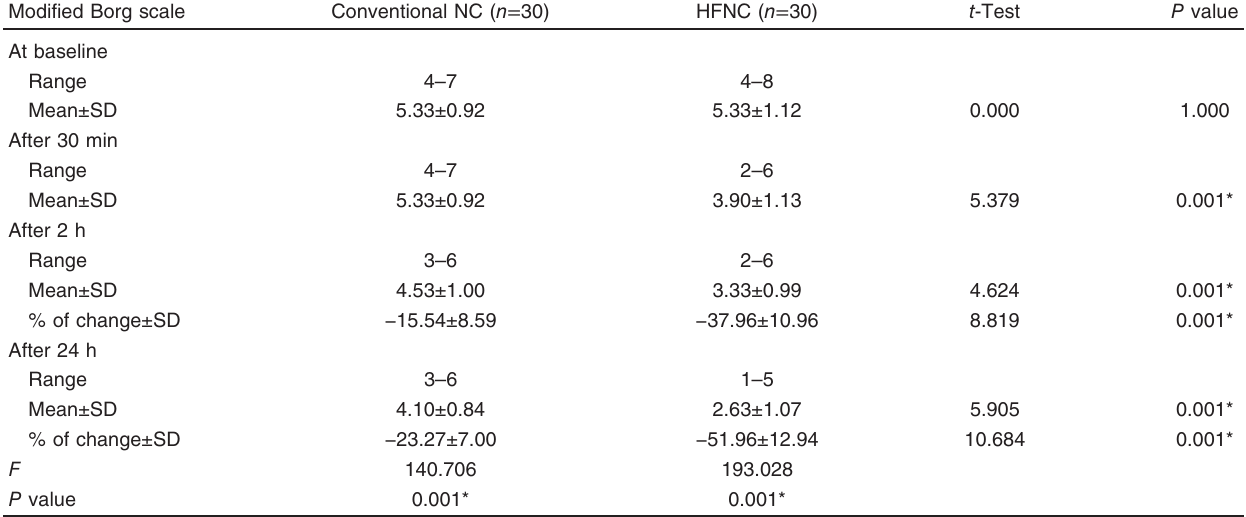
Table 2 Comparison of the modified Borg scale between the two studied groups Modified Borg scale